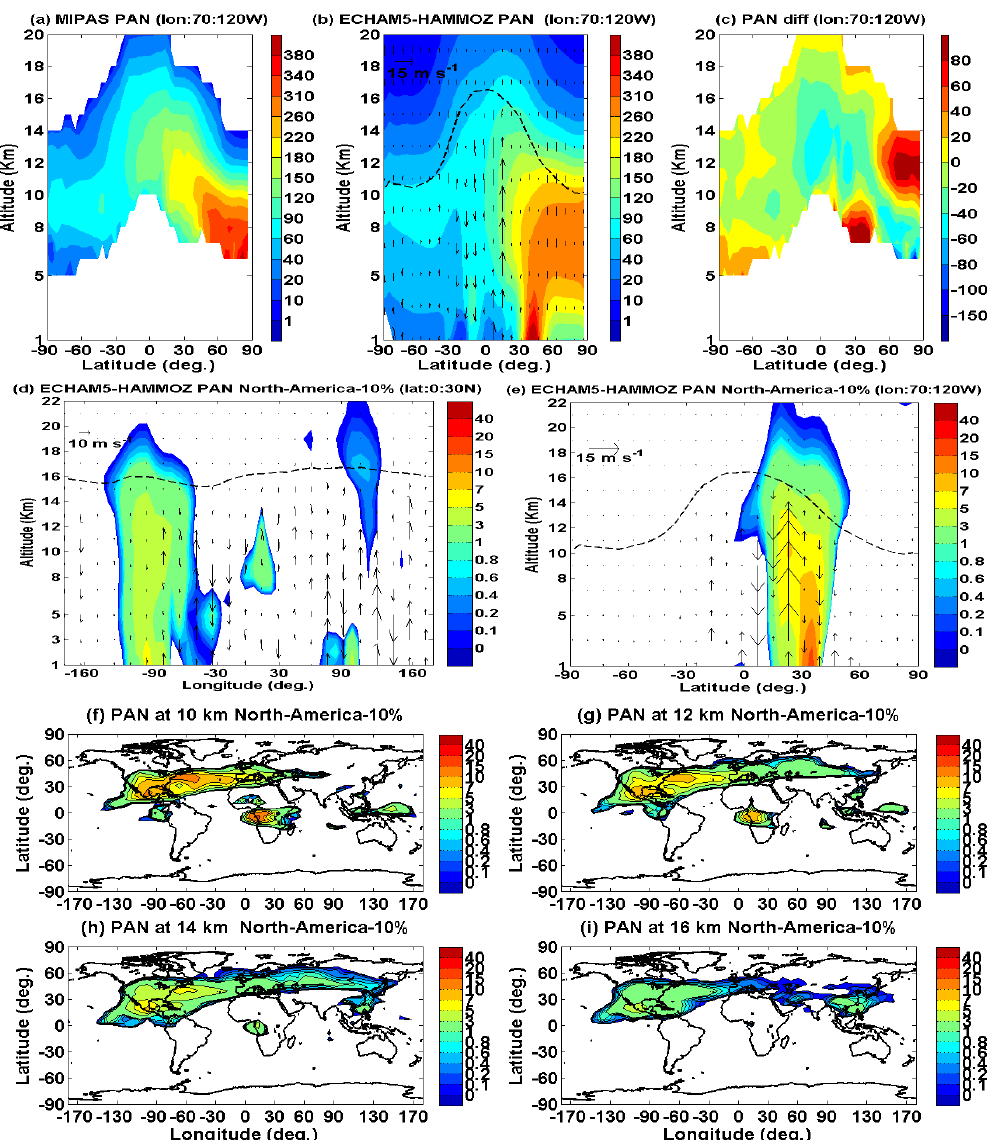
Figure 6. Latitude–altitude cross section of PAN (ppt) (a) MIPAS-E climatology, averaged for the monsoon season and for 70–120 ◦ W, (b) PAN from ECHAM5–HAMMOZ CTRL simulations, averaged for the monsoon season and 70–120 ◦ W, (c) difference in PAN (ppt) (MIPAS- ECHAM5–HAMMOZ), (d) longitude–altitude section averaged over 0–30 ◦ N obtained from reference–North America − 10% simulations (e) same as (d) but latitude–altitude section averaged over 70–120 ◦ W, (f) – (i) latitude–longitude sections of reference–North America − 10% simulations at 10, 12, 14, and 16km, respectively. Wind vectors are indicated by black arrows. The vertical velocity field has been scaled by